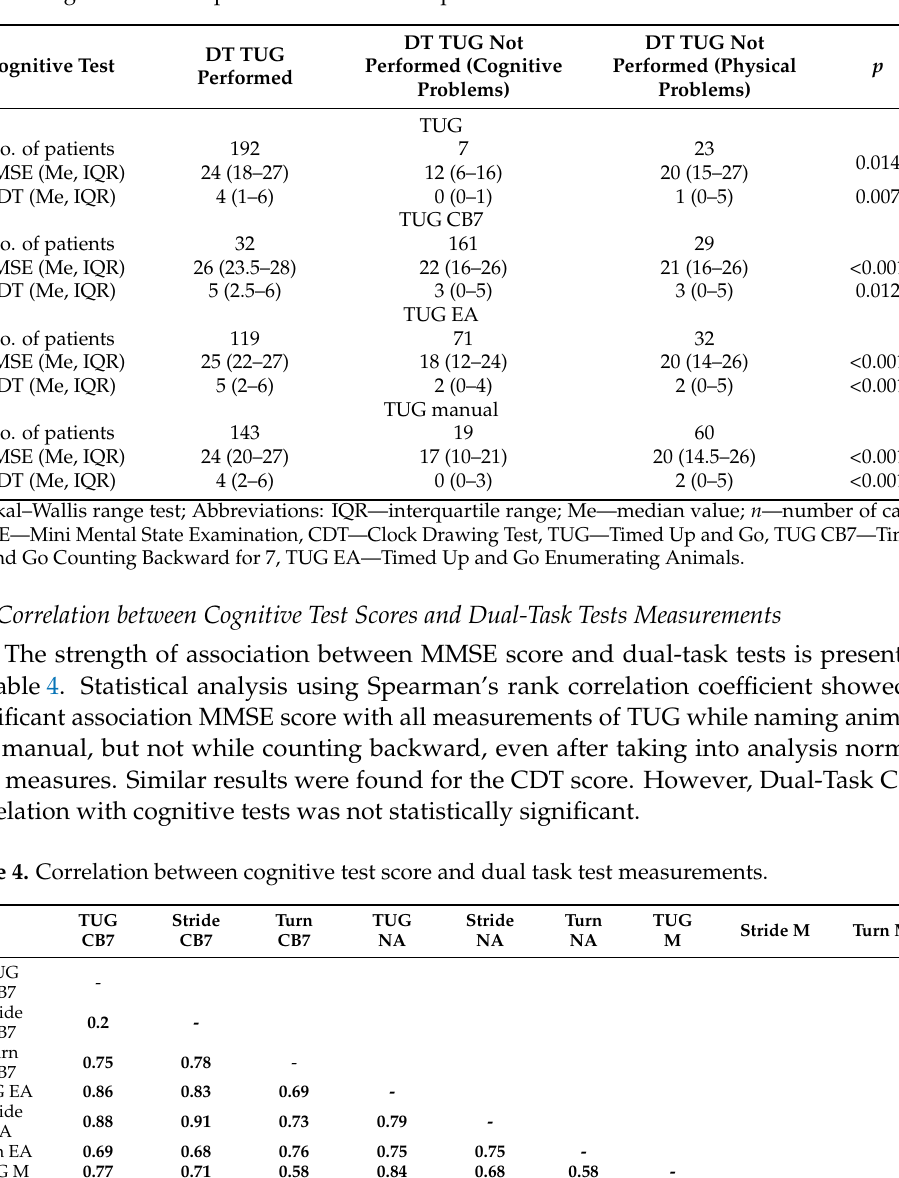
Table 3. Cognitive tests of patients with different performance of dual-task tests.